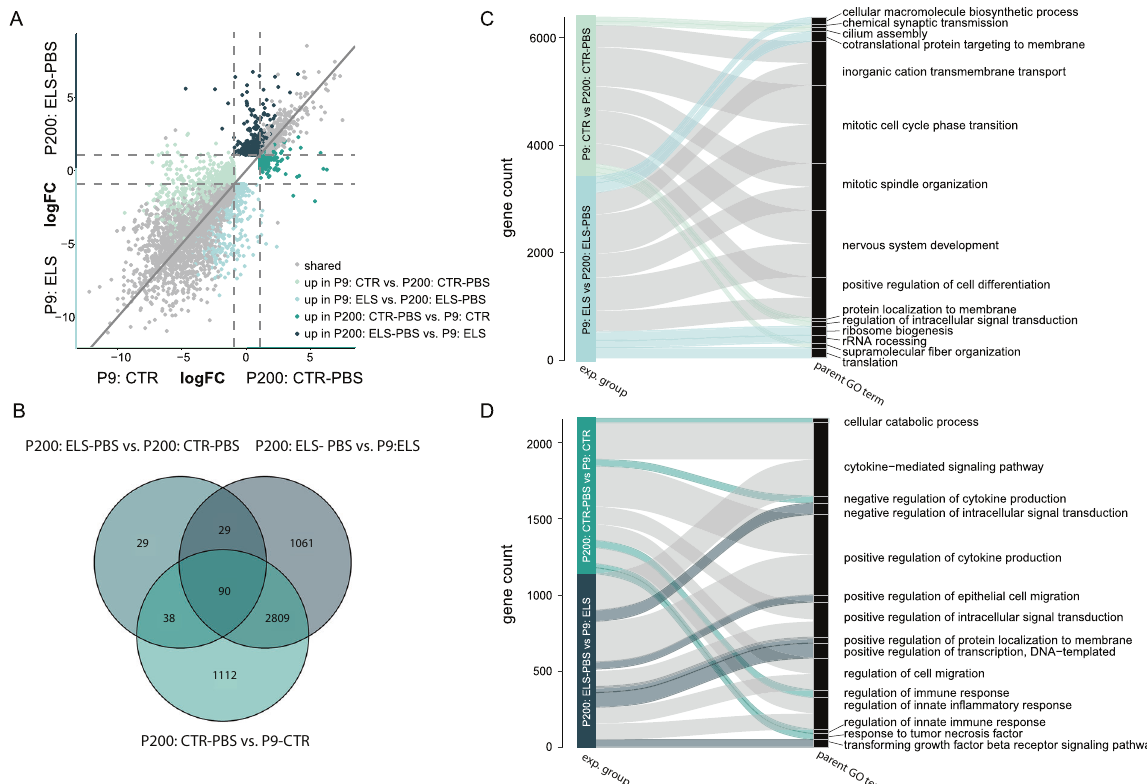
Fig. 2 ELS alters microglia development from P9 to P200. A Four-way plot depicting expression changes in developmental (P200 vs. P9)- associated genes in ELS and CTR microglia (logFC < />1, FDR < 0.05, Tables S8, S9). Each dot represents a gene. Light green dots mark DEGs uniquely enriched in CTR microglia of P9 compared to P200 animals. Light blue dots mark DEGs uniquely enriched in ELS microglia of P9 compared to P200 animals. Turquoise dots mark DEGs uniquely enriched in CTR microglia of P200 compared to P9 animals. Dark turquoise dots mark DEGs uniquely enriched in ELS microglia of P200 compared to P9 animals. Overlapping genes in the development from P9 to P200 of ELS and CTR microglia are marked in gray. B Venn diagram depicting the gene expression overlap of all DEGs between adult ELS effects (ELS vs. CTR, Table S3) and developmental effects (P200 vs. P9) in ELS and CTR microglia. C , D Alluvial plots illustrating the top 5 enriched parent GO terms P9- ( C ) and P200- associated ( D ) genes in CTR and ELS microglia. Signi fi cant GO terms ( p < 0.05) for each experimental group were reduced into parent GO terms (Tables S10, S11), which were ranked based on the total gene count belonging to that parent GO term. Color indicates the experimental group and ribbon thickness depicts the number of genes overlapping with parent GO term-speci fi c genes. CTR control, ELS early-life stress, exp. experimental, GO gene ontology, PBS phosphate-buffered